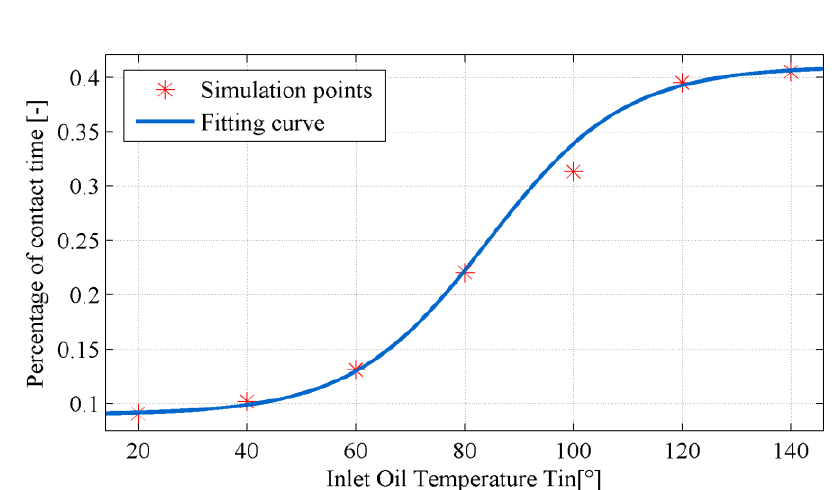
Figure 11. Curve of contact time with oil inlet temperature.